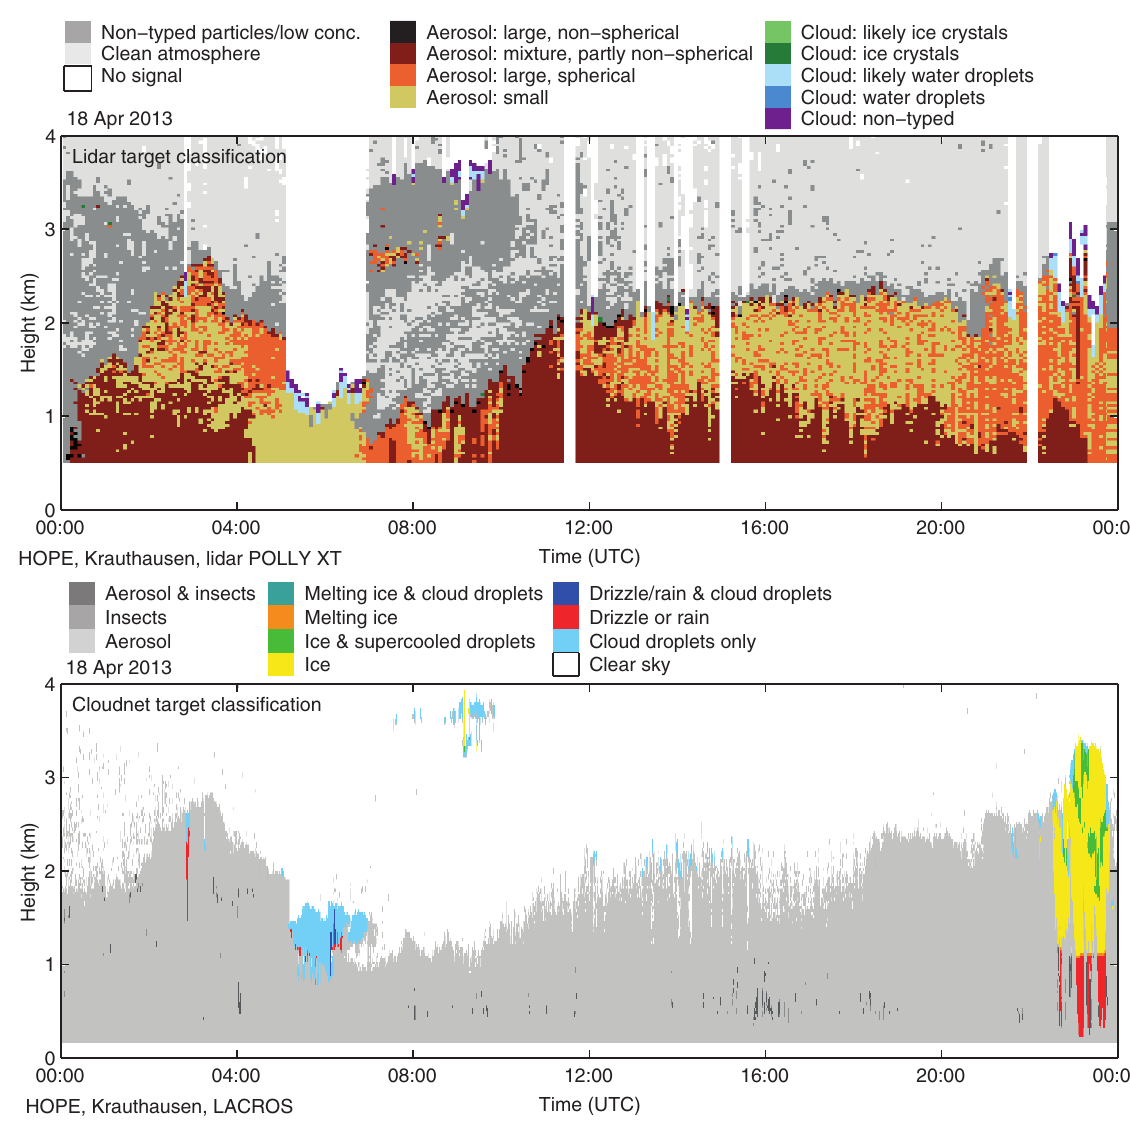
Figure 12. Lidar particle categorization (top) and Cloudnet target categorization (bottom) for 18 April